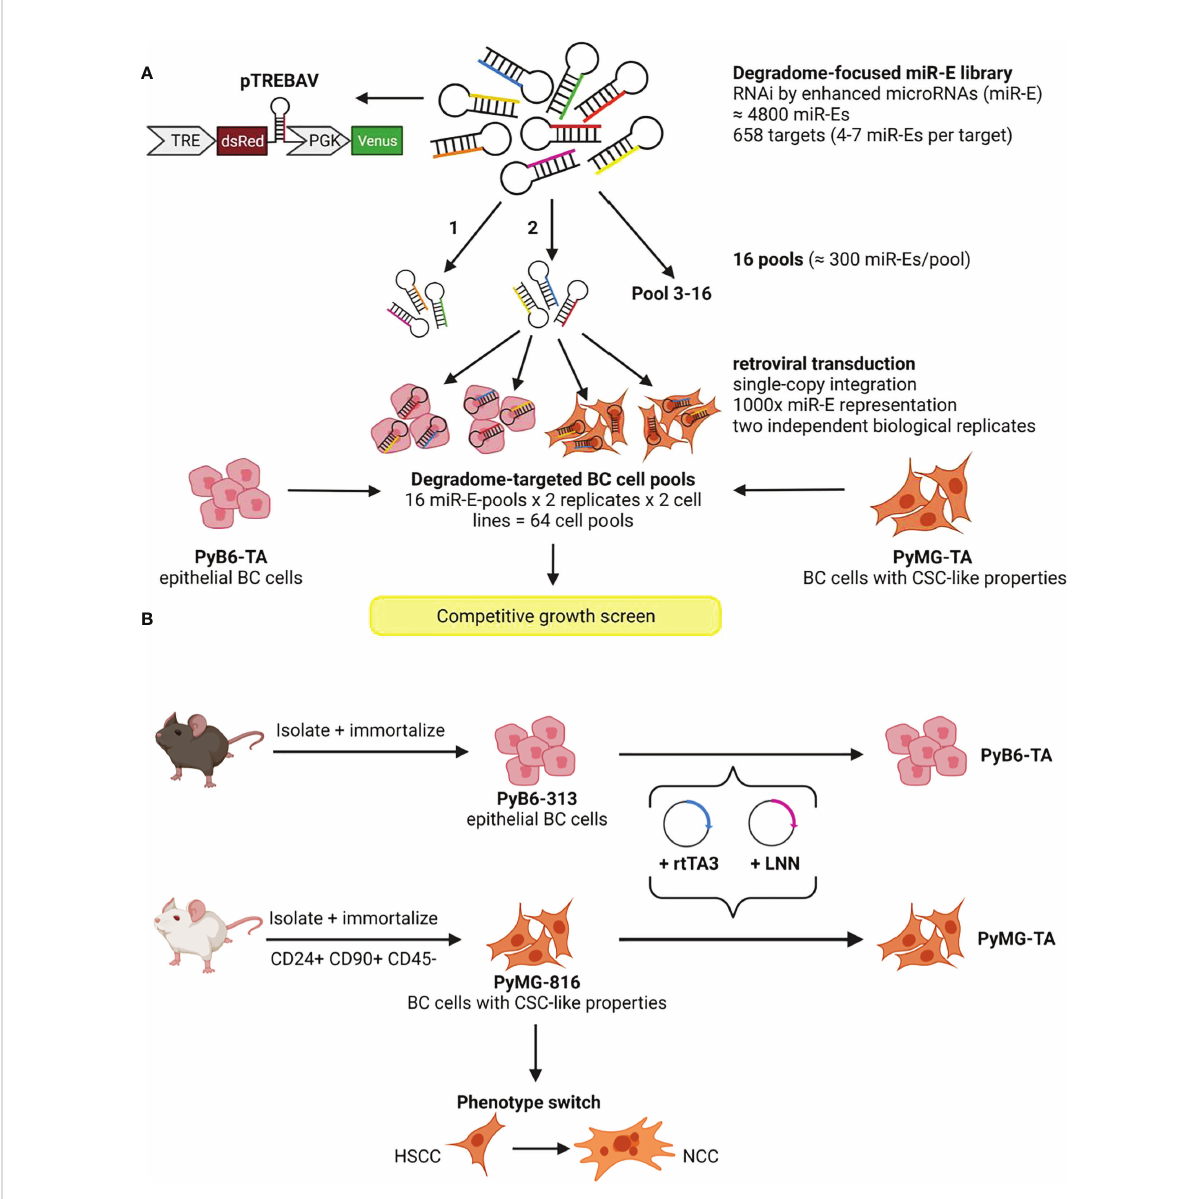
FIGURE 1 Generation of two degradome-targeted breast cancer cell lines. (A) Integration of a degradome-focused miR-E library into two MMTV-PyMT mouse model-derived breast cancer cell lines (PyB6-TA/PyMG-TA) leading to 64 cell pools for competitive growth screens. The miR-E library was inserted into the double- fl uorescence Dox-inducible TRE-dsRed-miR-E-PGK-BSDr-2A-Venus (pTREBAV) vector; broad scheme; miR-E guide sequence in orange. TRE, tetracycline response element; PGK, phosphoglycerate kinase. (B) Establishment of MMTV-PyMT mouse model- derived breast cancer cell lines from different mouse backgrounds. BC, breast cancer; CSC, cancer stem cell-like; HSCC, hypoxic cancer stem cell conditions; LNN, luciferase; NCC, normoxic culture conditions; rtTA3, reverse tetracycline